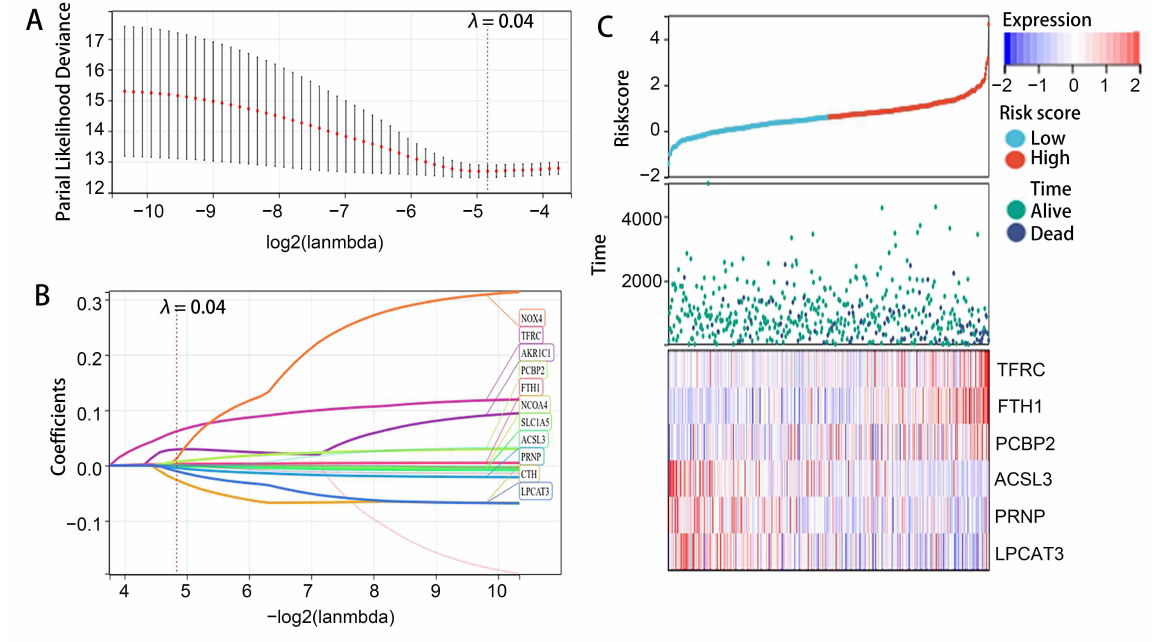
FIGURE 3. Lasso analysis of FRGs. (A) The lambda value and corresponding partial likelihood values for the prognosis model. (B) 11 FRGs were screened out in the optimal lambda. (C) Distribution of risk score, survival status and the expression of the 6 genes.